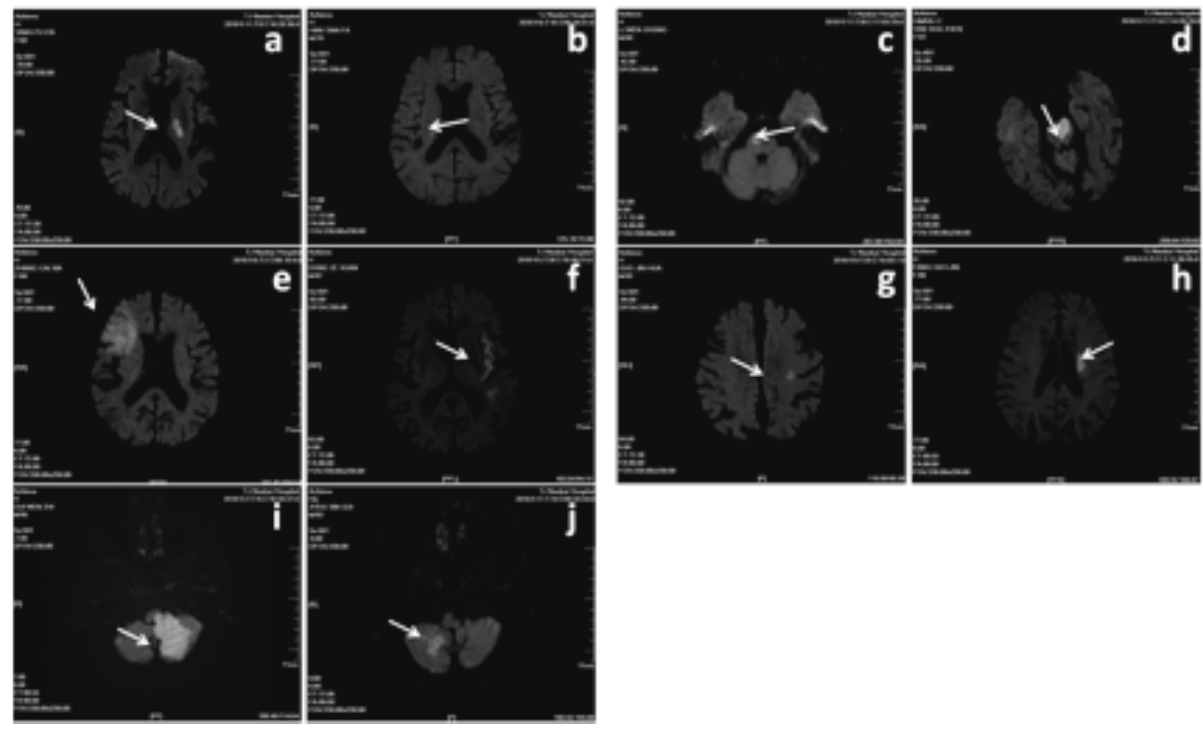
Figure 2: The MRI diagram of the infarct site of the included patients (a,b: Basal ganglia infarction; c,d: Brainstem infarction; e,f: Cerebral cortical infarction; g,h: Subcutaneous infarction; i,j: